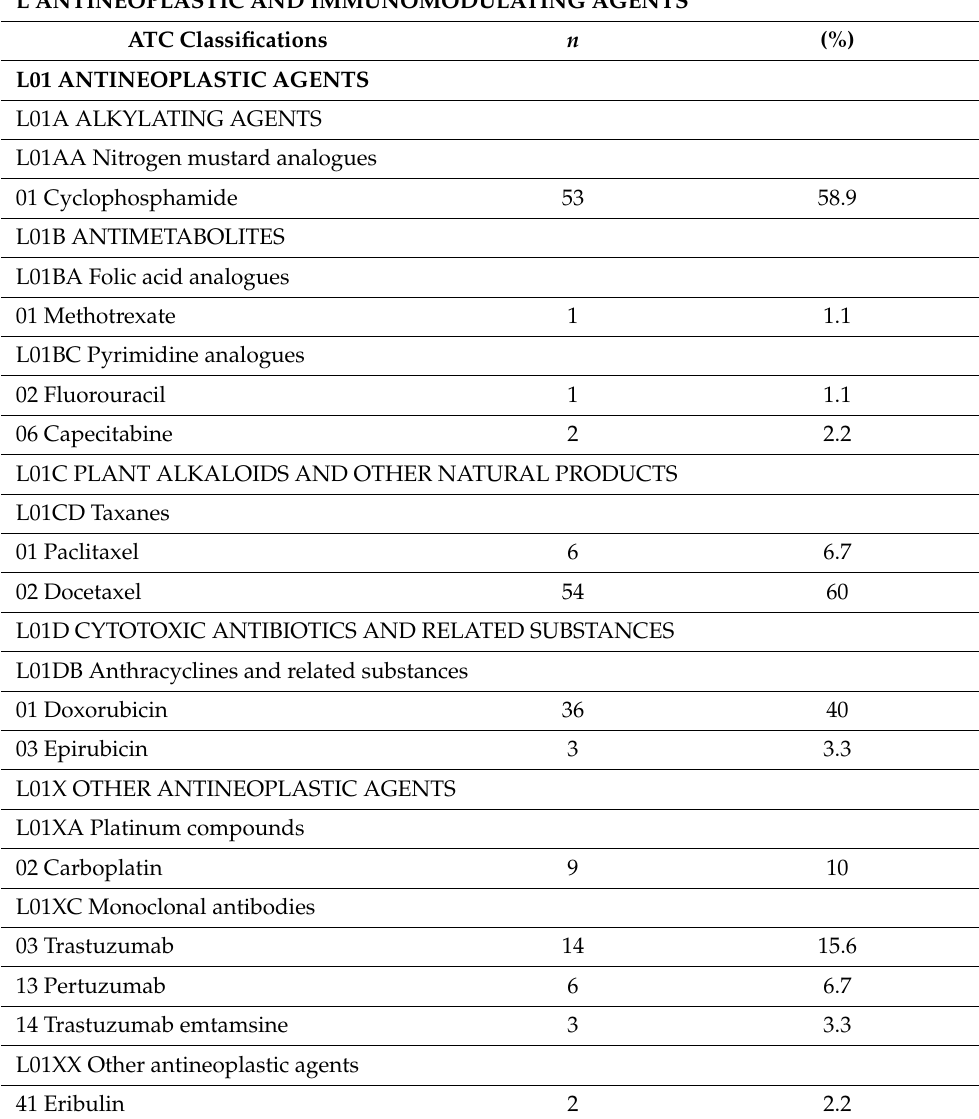
Table 2. CT+ treatment: antineoplastic agents. L ANTINEOPLASTIC AND IMMUNOMODULATING AGENTS ATC